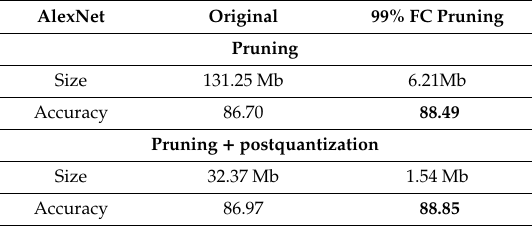
Table 7. Comparison in terms of size and accuracy before and after compression of AlexNet FC-layer on the plant seedlings database.